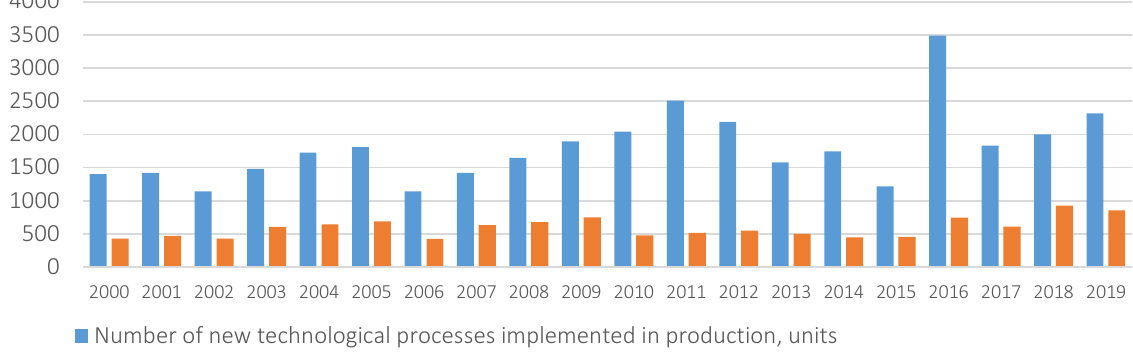
Figure 2. Number of new technological processes implemented in production, 2000–2019